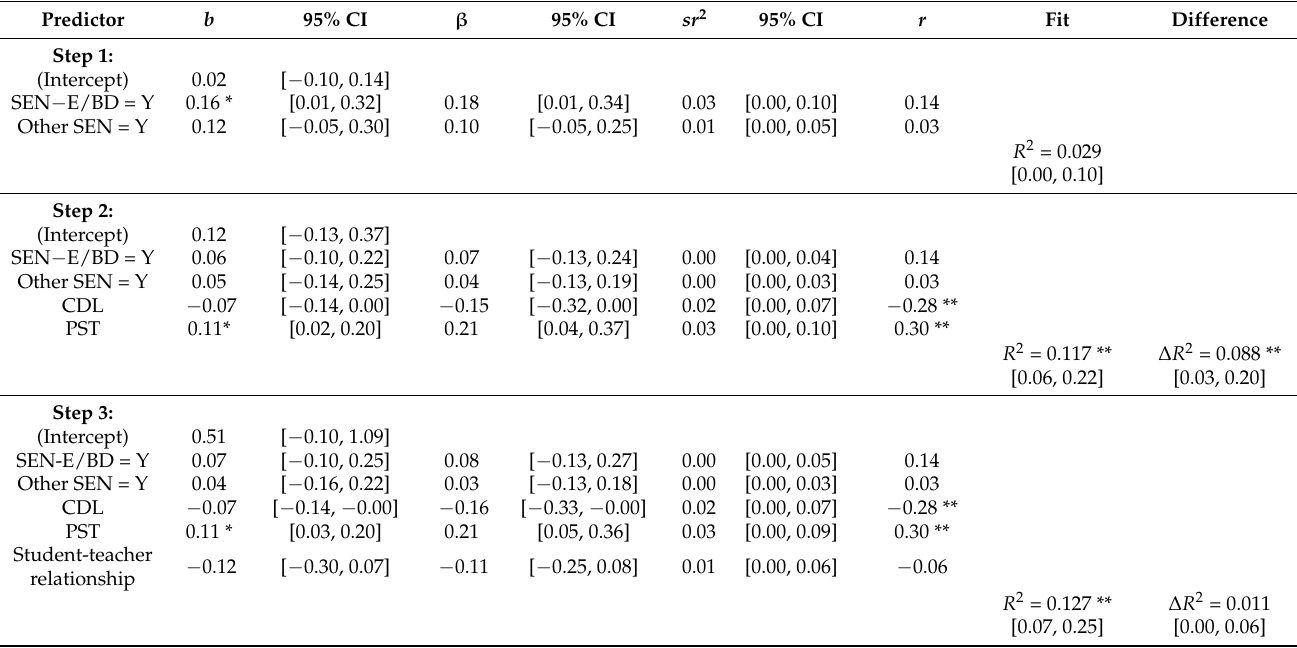
Table 6. Regression results using the lockdown effect on EP as the criterion.